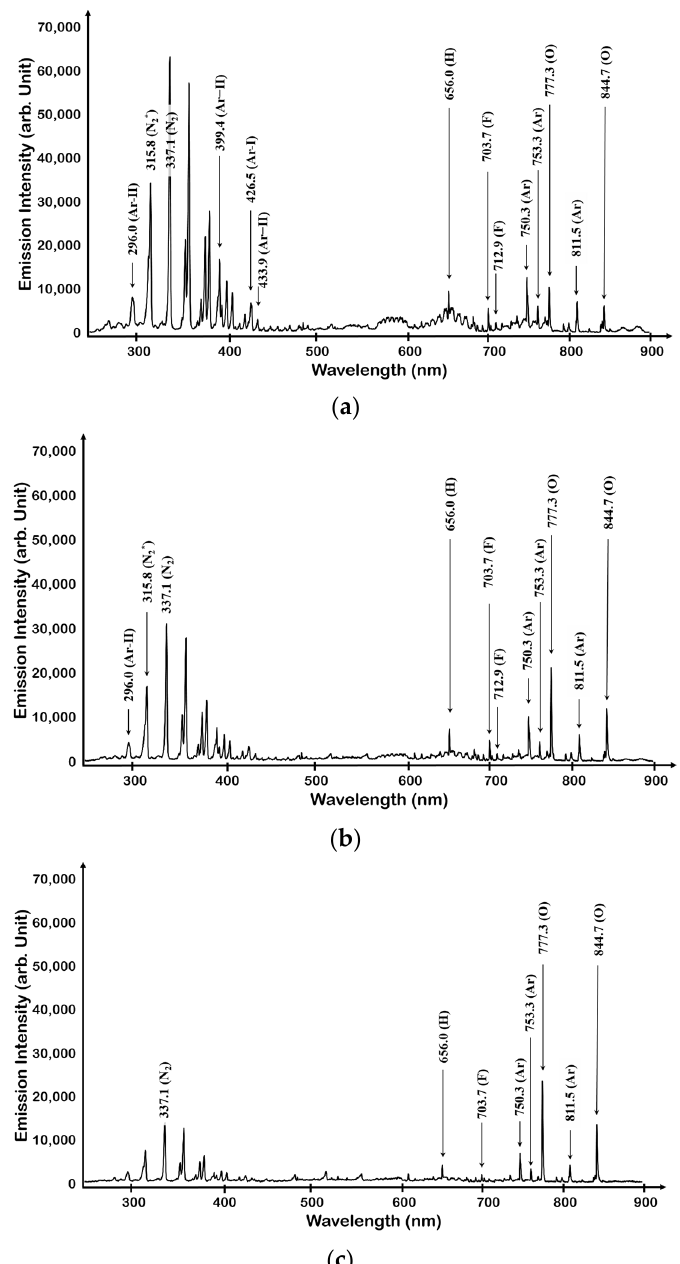
Figure 7. OES spectrum of NF 3 + O 2 plasma: ( a ) case of NF 3 + O 2 (80:20), ( b ) case of NF 3 + O 2 (50:50), and ( c ) case of NF 3 + O 2 (20:80).